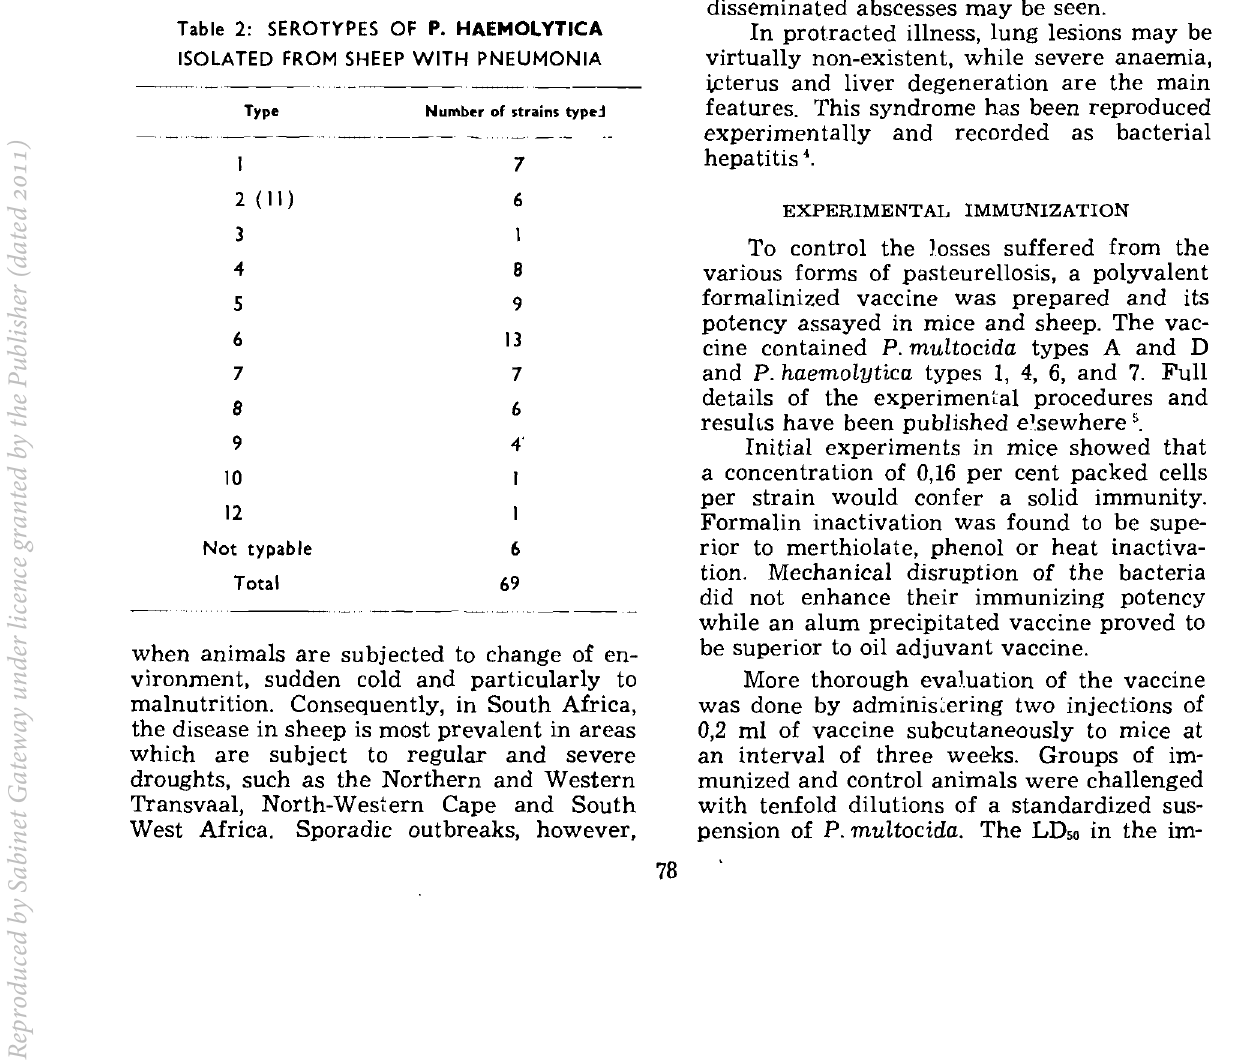
Table 2: SEROTYPES OF P. HAEMOLYTICA ISOLATED FROM SHEEP WITH